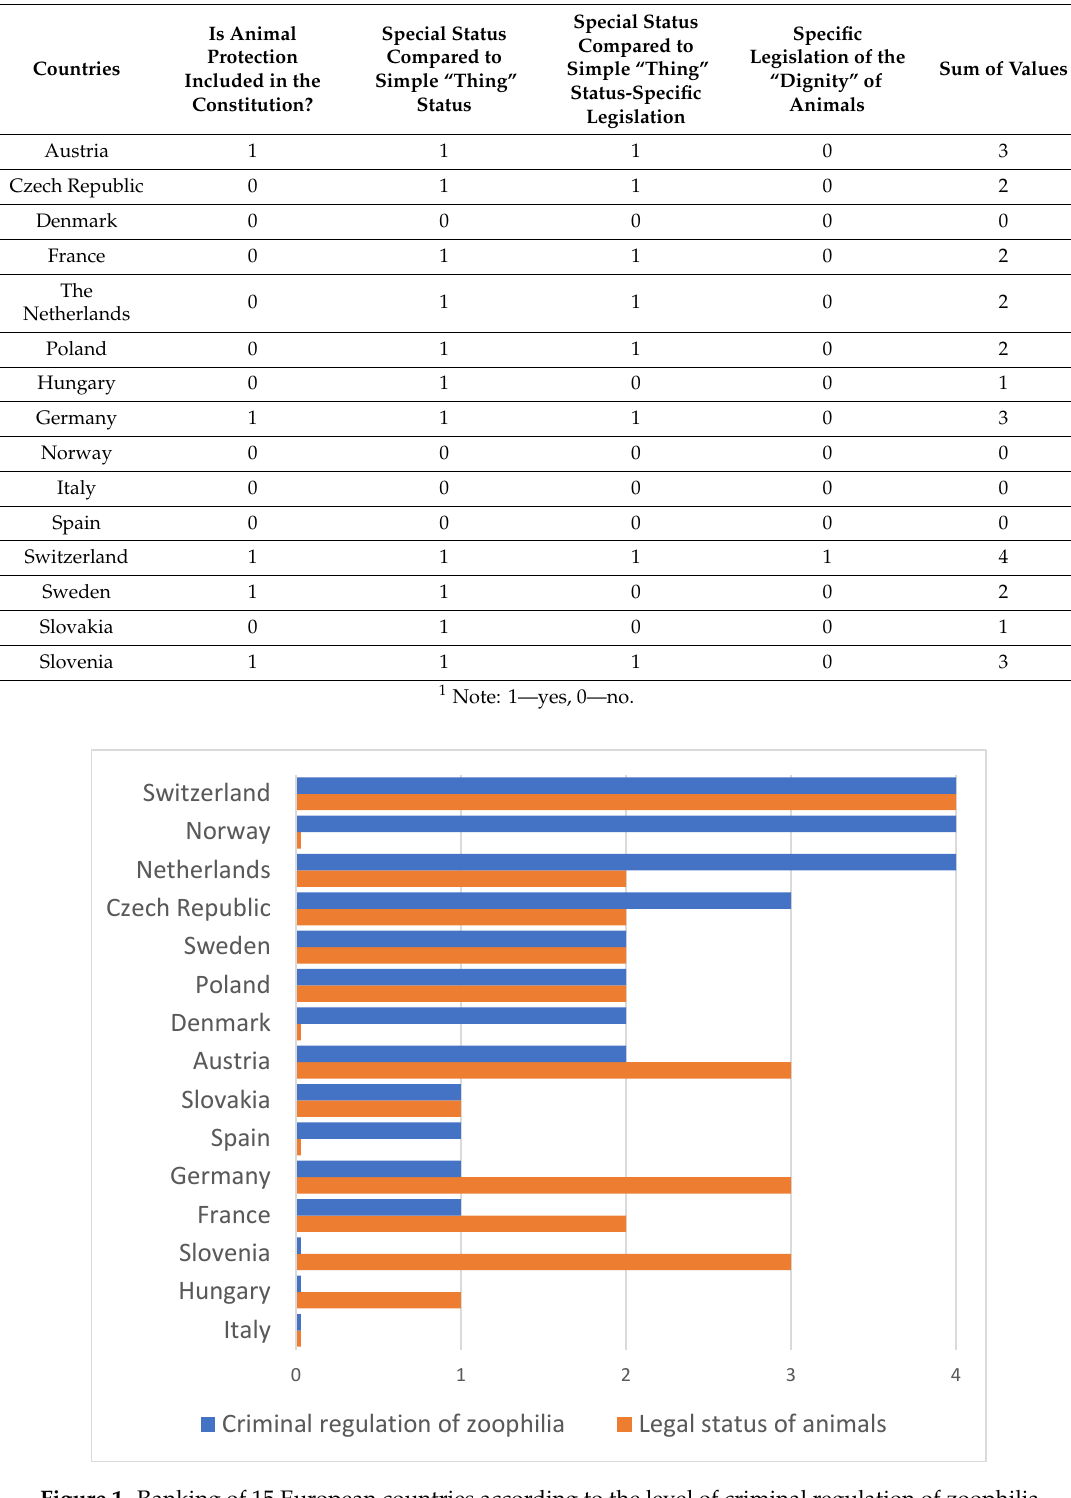
Figure 1. Ranking of 15 European countries according to the level of criminal regulation of zoophilia and the legal status of animals (based on the sum of values, from the most complete legal regulation (4) to the absence of regulation (0)).